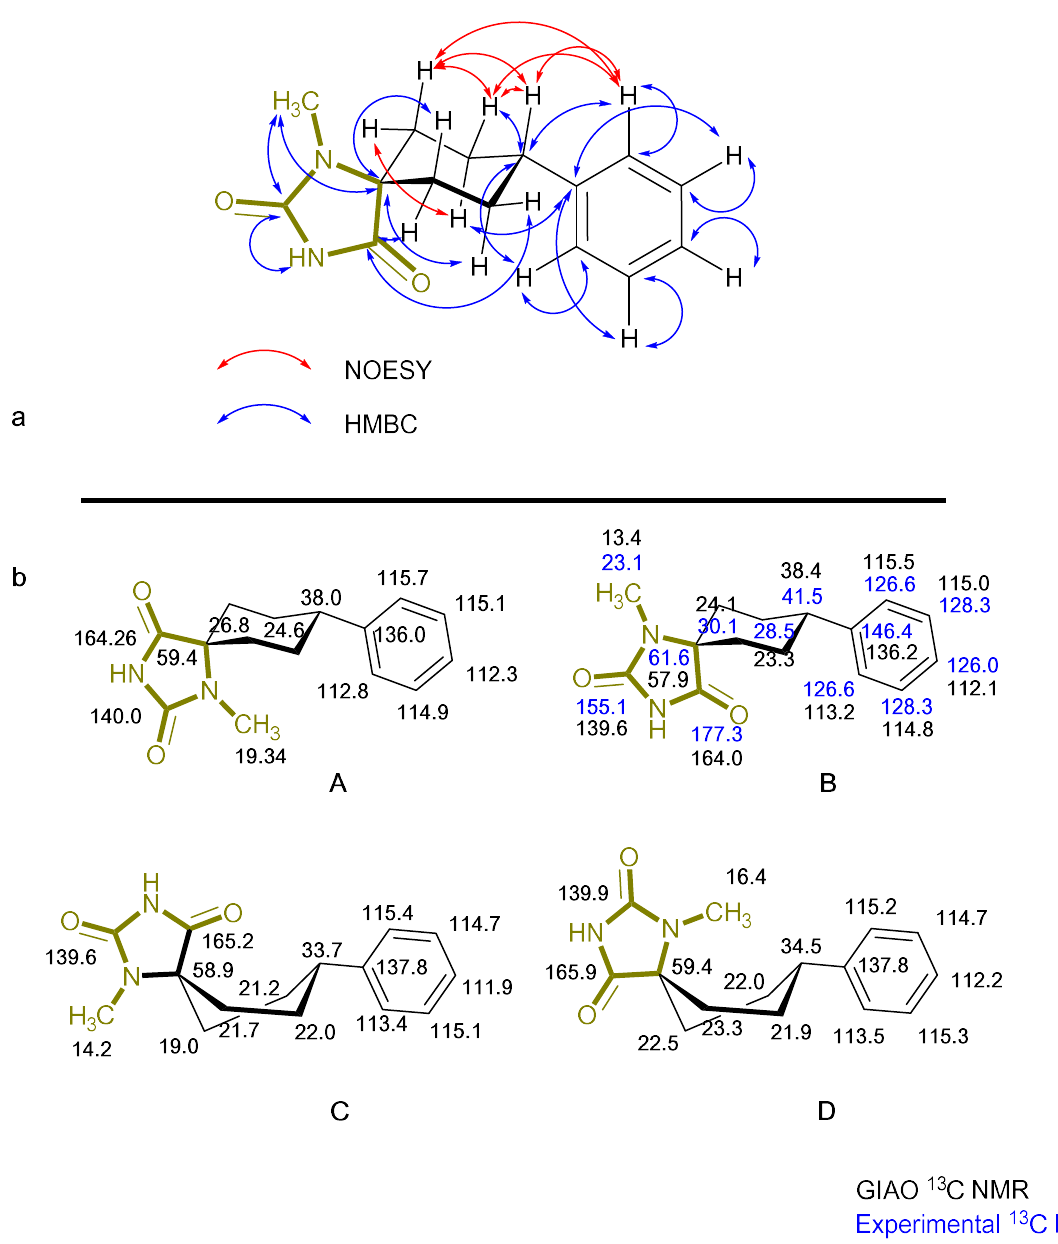
Figure 3. ( a ) Representation of experimental NMR data for ( 4 ) with HMBC correlations illustrated as blue two-way bent arrows and NOESY illustrated as red two-way bent arrows. ( b ) GIAO predicted 13 C NMR chemical shifts of all conformers with black writing and experimental shifts for the assigned conformer B in a blue color.